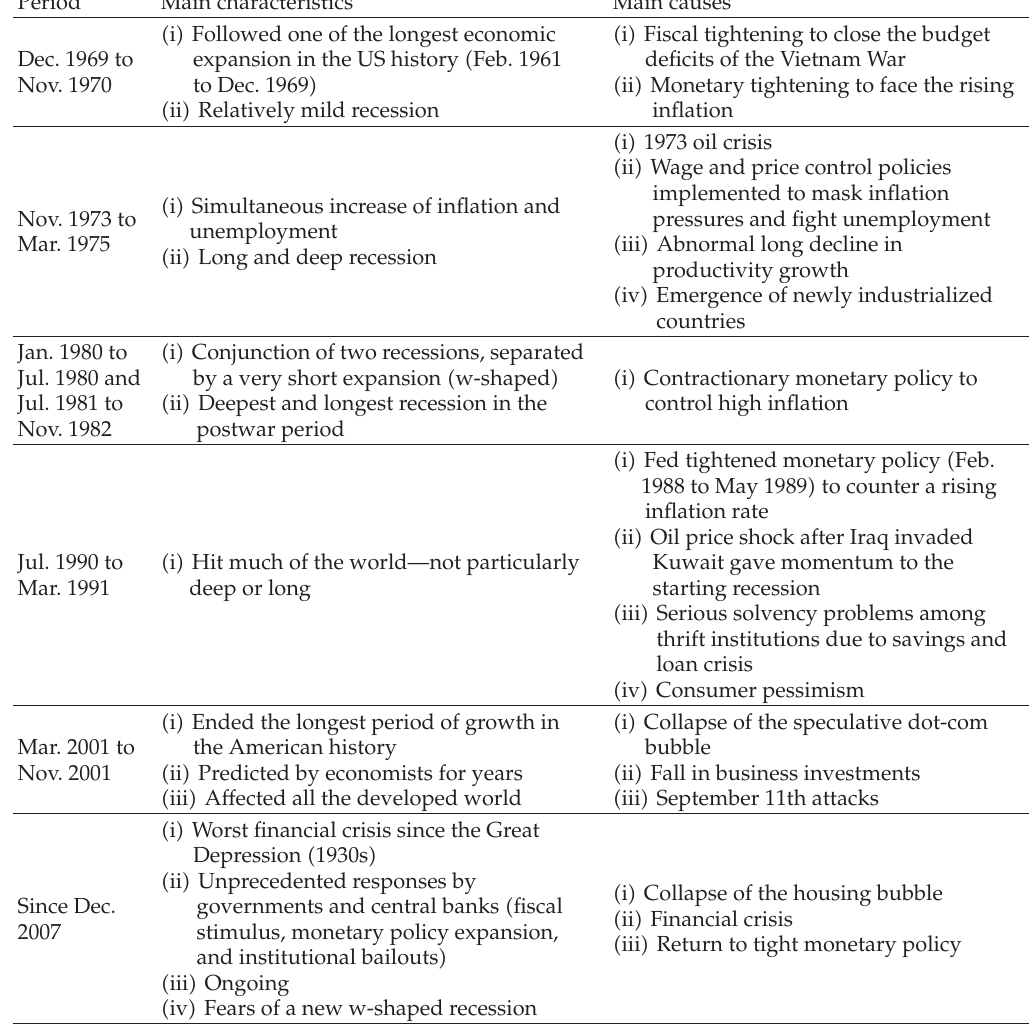
Table 1: Business cycle reference dates, in US, since 1970. Period Main